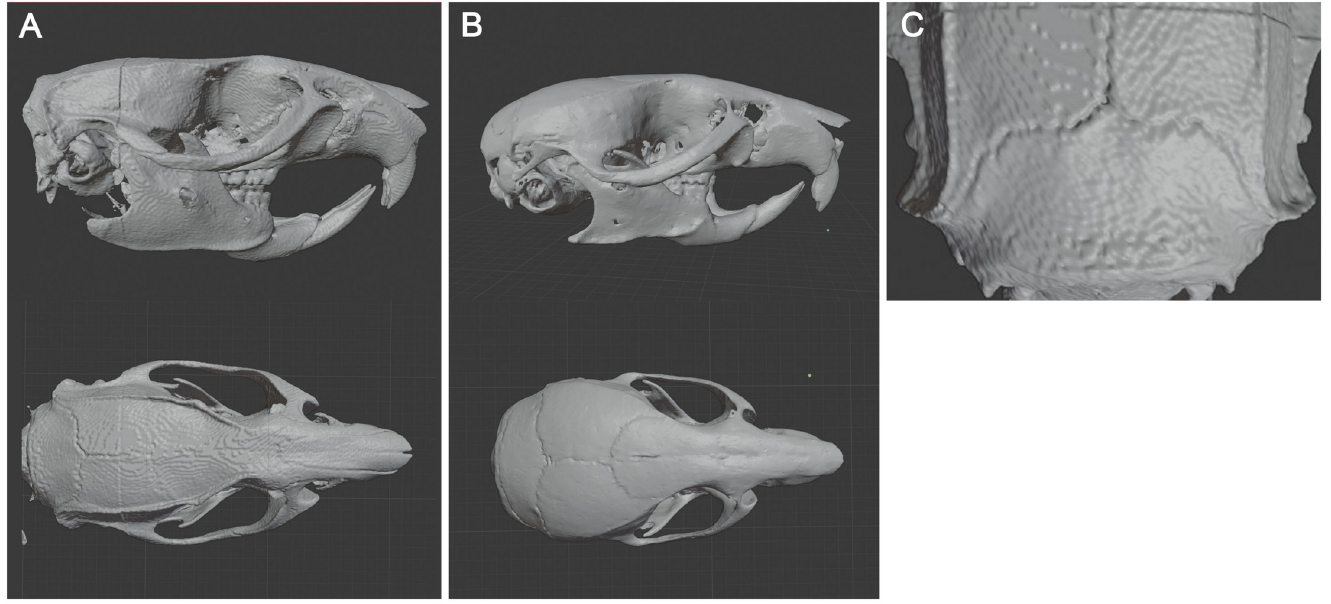
Fig 1. 3D models of rat and mouse skull. (A) Rat skull model. (B) Mouse skull model. (C) Close up of